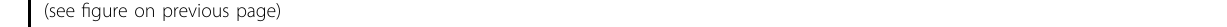
Fig. 4 DA-DRD5 signaling can inhibit M1 polarization by negatively regulating NF- κ B signaling and promote M2 polarization through the activation of the CREB pathway. A Principal component (PC) analysis of transcriptional clustered architecture in M1-stimulated WT and DRD5 − / − BMDMs untreated or treated with DA (20 μ M) ( n = 3). B Gene set enrichment analysis (GSEA) analysis of the prominent down-regulated pathways in M1-stimulated WT BMDMs untreated or treated with DA (left) or M1-stimulated WT and DRD5 − / − BMDMs treated with DA (right). C Immunoblot analysis of phosphorylated (p − ), and total IKK α / β , I κ B α in lysates of LPS/IFN- γ -stimulated WT and DRD5 − / − BMDMs untreated or treated with DA (20 μ M) as indicated. D Heat map showing the expression of NF- κ B-mediated M1 genes in LPS/IFN- γ -stimulated WT and DRD5 − / − BMDMs untreated or treated with DA. E PC analysis of gene expression cluster in M2-stimulated WT and DRD5 − / − BMDMs untreated or treated with DA (20 μ M) ( n = 3). F GSEA analysis of the prominent upregulated pathways in M2-stimulated WT BMDMs untreated or treated with DA (left) or M2-stimulated WT and DRD5 − / − BMDMs treated with DA (right). G Immunoblot analysis of phosphorylated (p − ), and total CREB, PKAc in lysates of IL-4/IL-13-stimulated WT and DRD5 − / − BMDMs untreated or treated with DA (20 μ M) as indicated. H Heat map showing the expression of genes associated with M2 macrophage in IL-4/IL-13-stimulated WT and DRD5 − / − BMDMs untreated or treated with DA. Data are representative of three independent experiments ( C , G